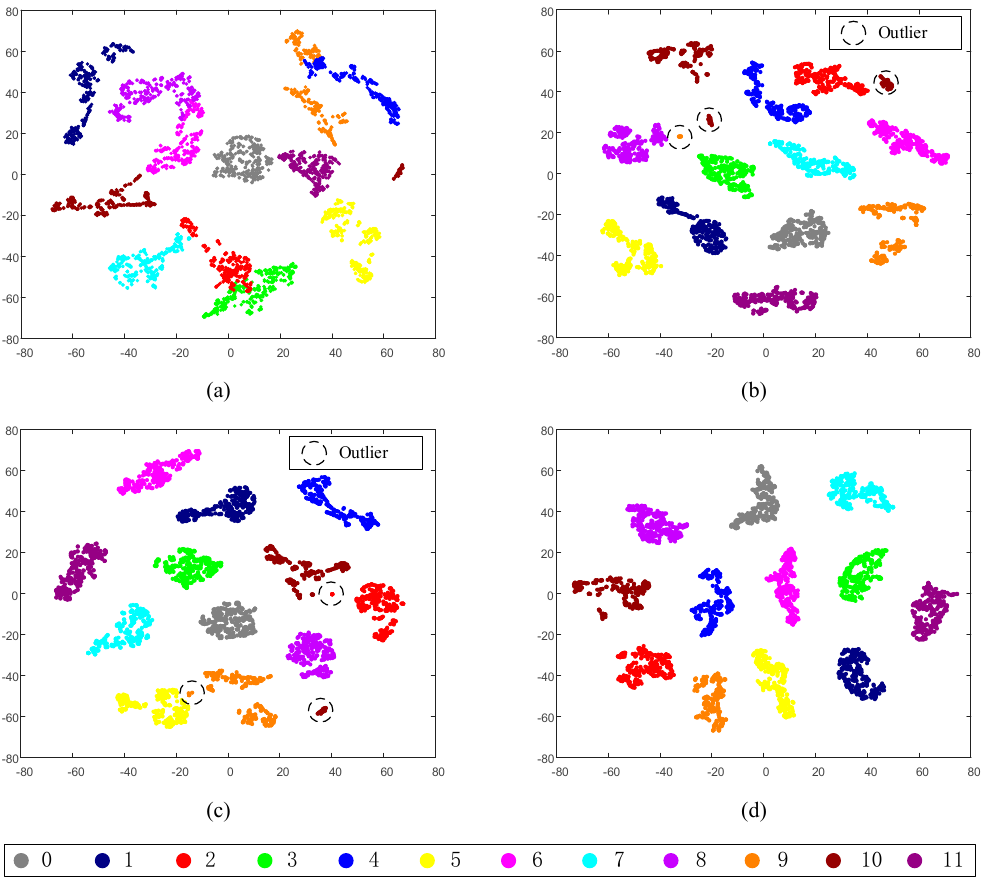
Figure 9. 2D visualization of the learned features: ( a ) raw data, ( b ) general CNN, ( c ) SIF-CNN and ( d ) SSIF-CNN.